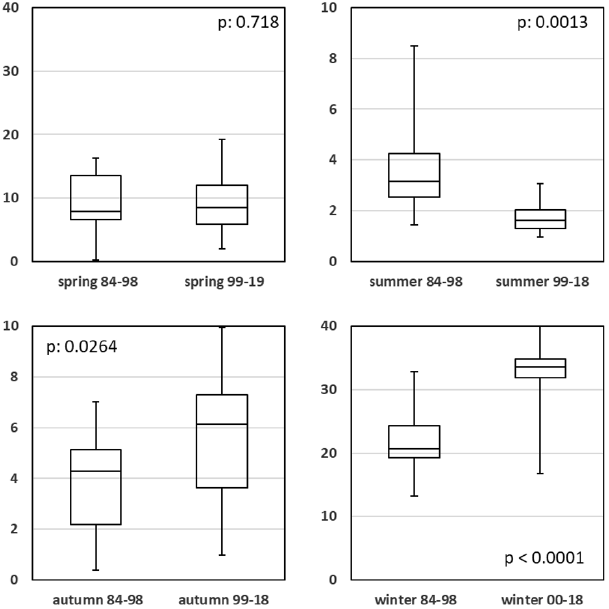
Figure 7. Seasonal comparison of reactive silicate concentrations (µmolL − 1 ) for high and low eutrophication periods.